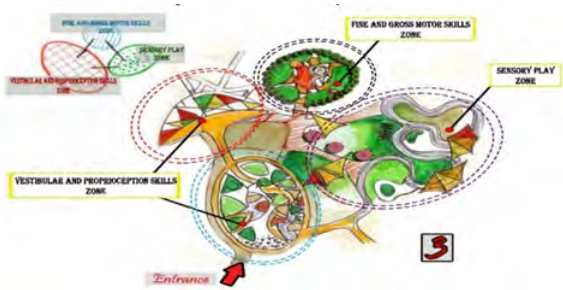
Figure 11. Zoning diagram for the sensory zone